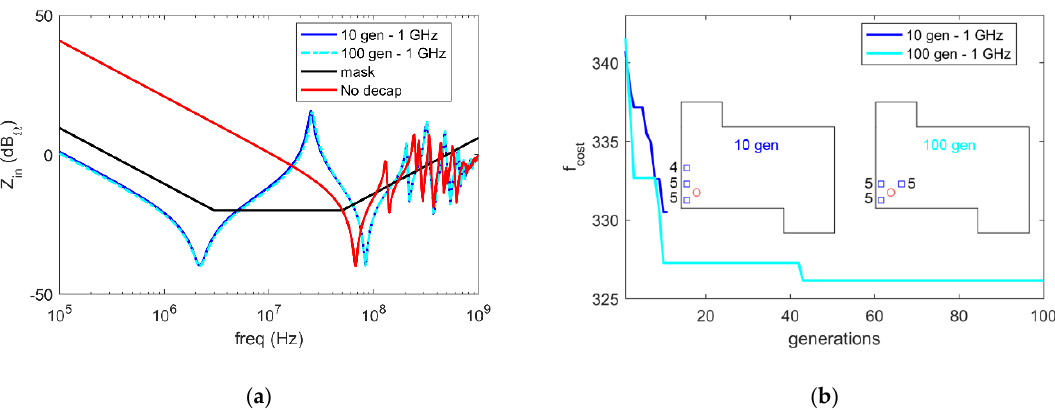
Figure 10. ( a ) Result of the optimization in EZpp up to 1 GHz after 10 generations (solid blue line) and 100 generations (dotted–dashed cyan line) compared with the mask and the case without decaps. ( b ) Cost function f cost as function of the number of generations when max gen = 10 and max gen = 100. The insets show the decaps placement after as max gen changes its value and the number of elementary decaps in each position. The red circle represents the input port and the blue squares the position for the